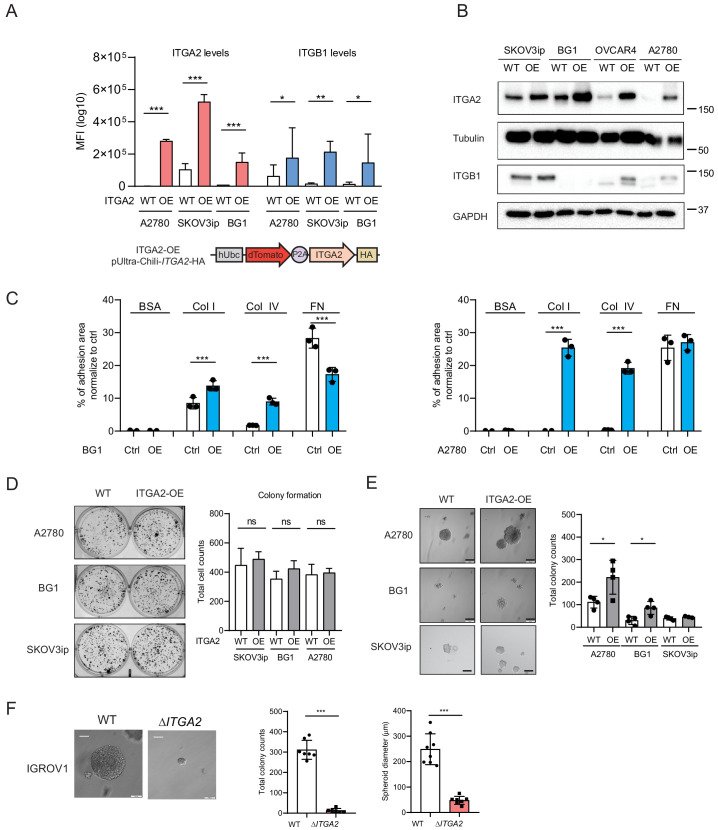
Characterization of constitutive ITGA2 expression in selected ovarian cancer cell lines.(A) The levels of ITGA2 and ITGB1 expression in WT versus ITGA2-overexpression (OE) in SKOV3ip, BG1, OVCAR4, and A2780 cell lines were determined by flow cytometry and (B) Western blot. (C) Cell-ECM adhesion assay of WT and ITGA2 overexpressed (OE) ovarian cancer cells. Bar chart summarizes percentage of cell to ECM adhesion efficiency from three independent experiments (***p<0.001, unpaired Student’s t-test). (D) Colony formation assay for WT and OE cells for 7 days. Bar chart represents the mean ± SD of total colony counts. (E) Anchorage-independent soft agar assay for WT and OE cells for 10 days in culture. Bar chart shows the quantification of total spheroid numbers (*p<0.05, unpaired Student’s t-test). Scale bar 200 μm. (F) Anchorage-independent growth for IGROV1 WT and ΔITGA2 cells for 10 days in culture. Bar chart shows quantification of total spheroid numbers and diameter in μm (***p<0.001, unpaired Student’s t-test). Scale bar 100 μm.